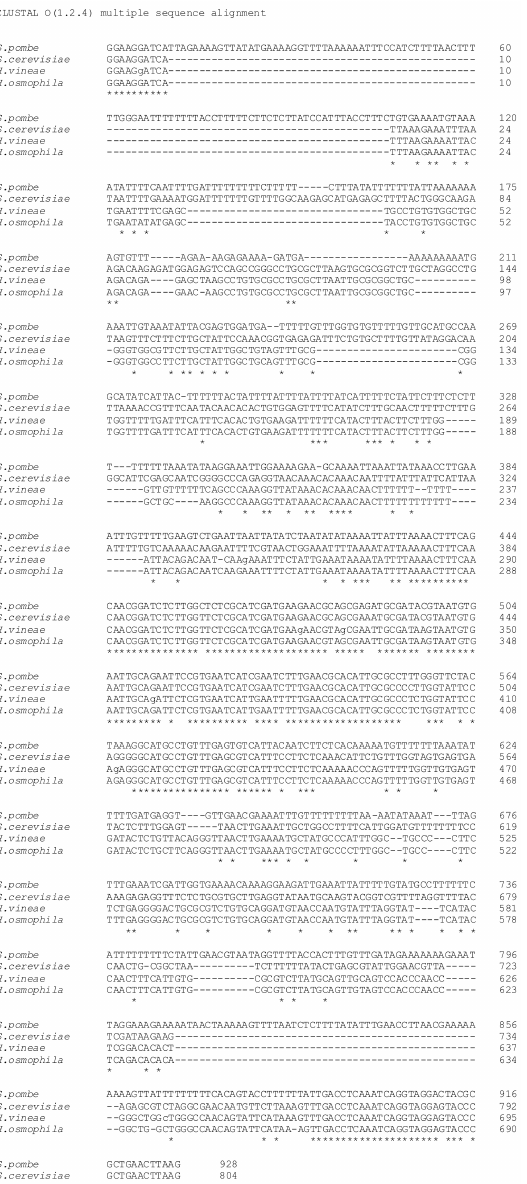
Figure A2. Multiple alignments of complete 5.8S rDNA sequence and Internal Transcribed Spacer 1 and 2 sequences, for: Schizosaccharomyces pombe , Saccharomyces cerevisiae , Hanseniaspora vineae and Hanseniaspora osmophil